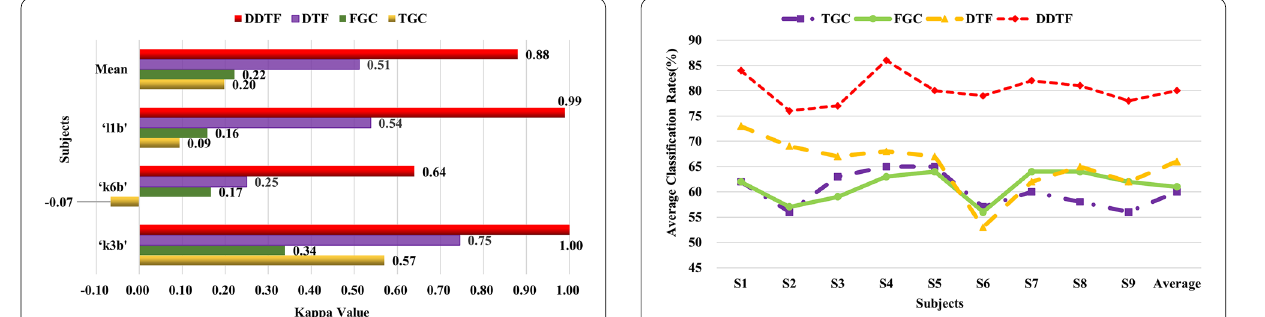
Fig. 15 Comparison of Kappa coefficients with GC-based brain functional network methods